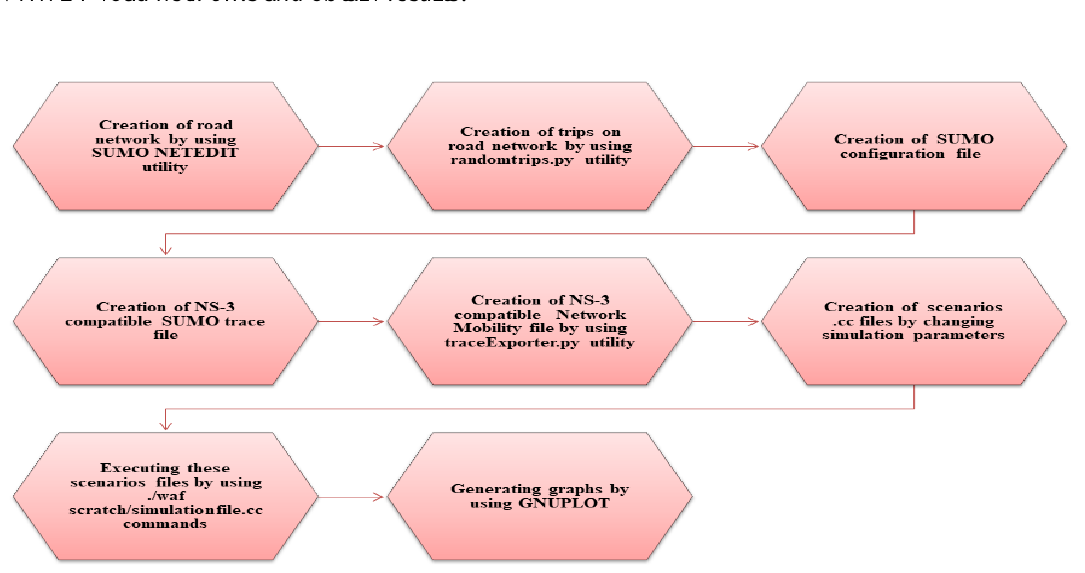
Table 2 summarizes the network parameters for topology-based and position-based routing protocols used in our experiments.